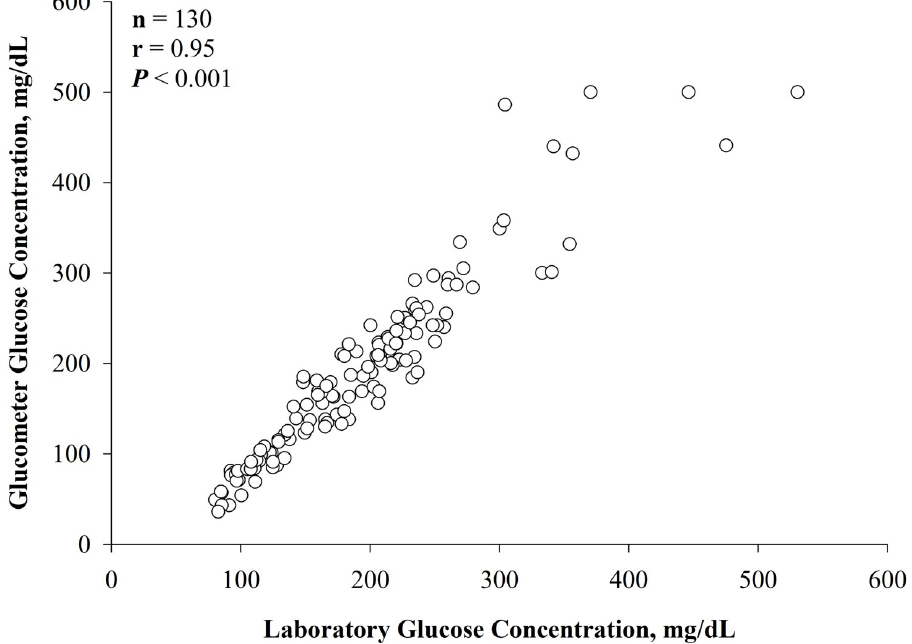
Fig 1. Pearson correlation coefficient ( P < 0.001, r = 0.95) of the raw data (N = 130 samples from 13 steers), with the glucose concentration as measured by the glucometer on the y-axis (Precision Xtra; Abbott Diabetes Care, Inc., Mississauga, ON, Canada) plotted against the plasma preserved in sodium fluoride tubes and analyzed in a laboratory with a colorimetric assay (Stanbio Glucose LiquiColor (Oxidase) Procedure, Stanbio Laboratory, Boerne, TX, USA) on the